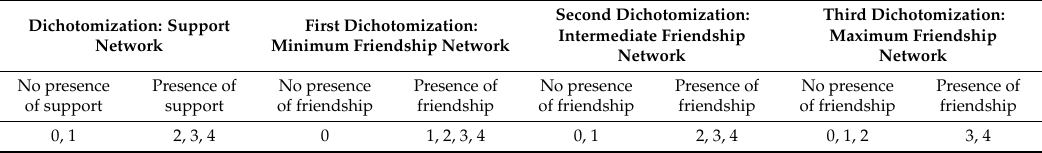
Table 2. Dichotomization process, Type 1 Support and Friendship